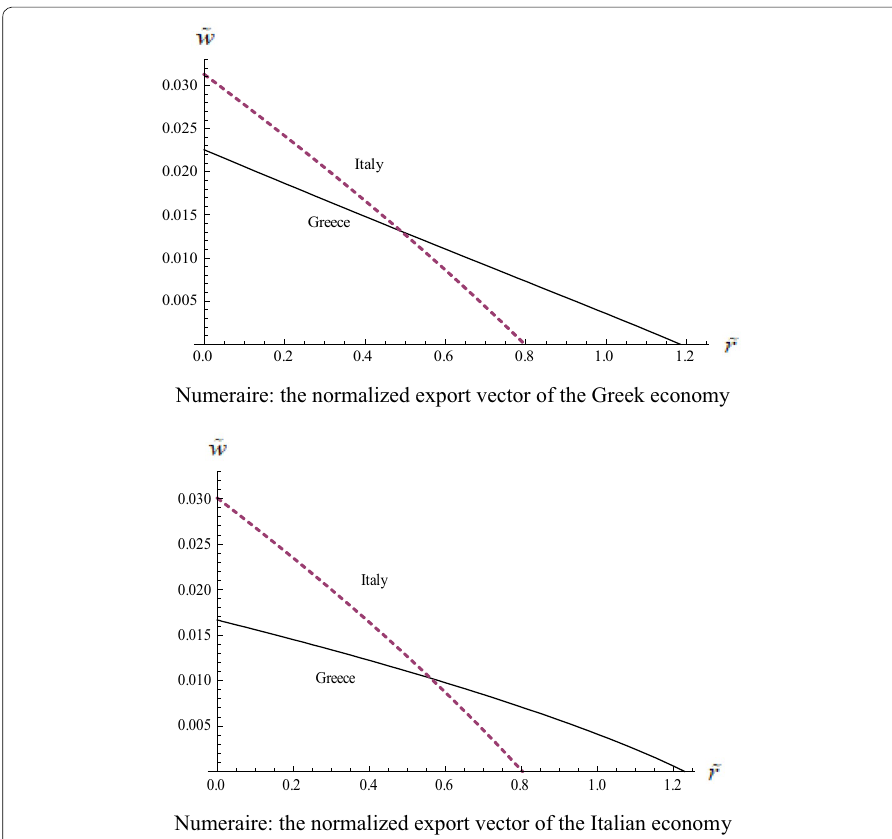
Fig. 5 The wage-profit rates trade-off; Greek and Italian